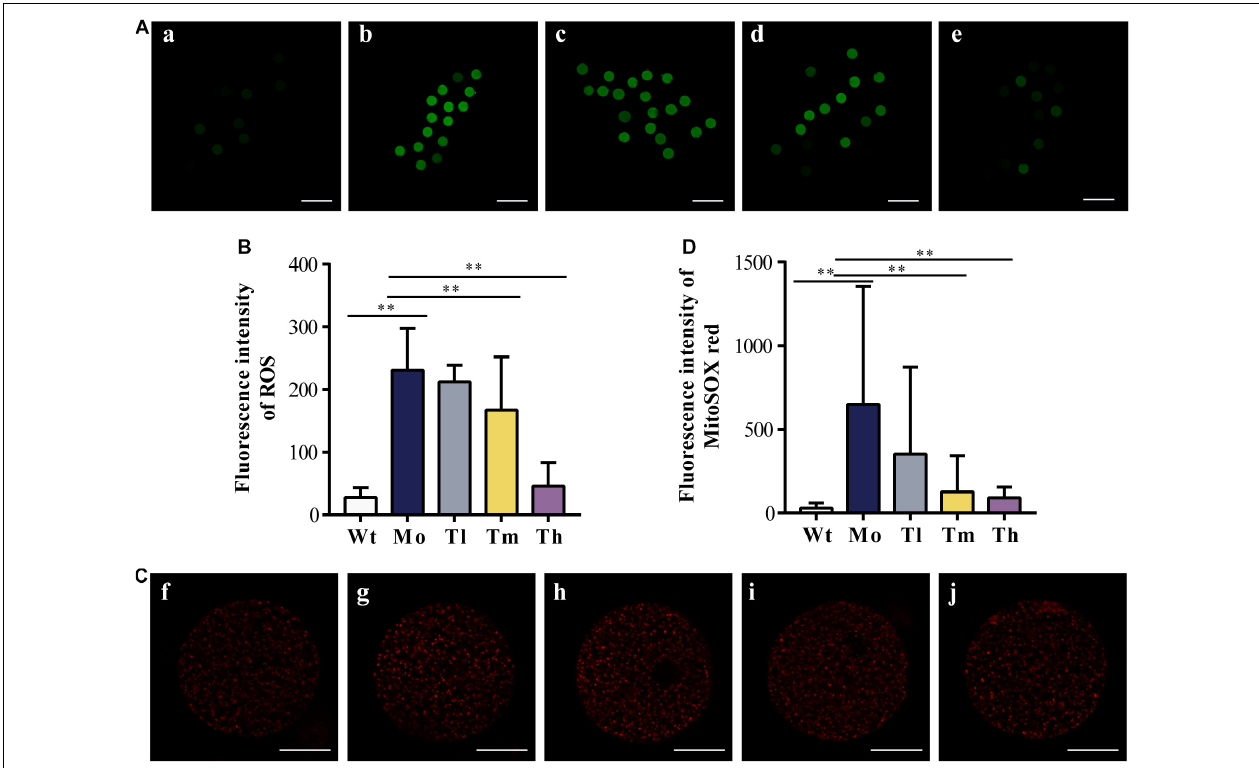
FIGURE 3 | Oxidative stress response to CTX and rhGH treatment. (A,B) Representative images of the contents of ROS (reflected by the intensity of green fluorescence. a, b, c, d, and e for the Wt, Mo, Tl, Tm, and Th groups, respectively. n ≥ 9, ∗∗ P < 0.01, scale bar = 200 µ m, × 40 magnification) from each group and quantitative analysis shown as the histogram. (C,D) Typical images of the contents of mitochondrial superoxide (reflected by the intensity of red fluorescence. f, g, h, i, and j for the Wt, Mo, Tl, Tm, and Th groups, respectively. n ≥ 8, ∗∗ P < 0.01, scale bar = 25 µ m, × 400 magnification).